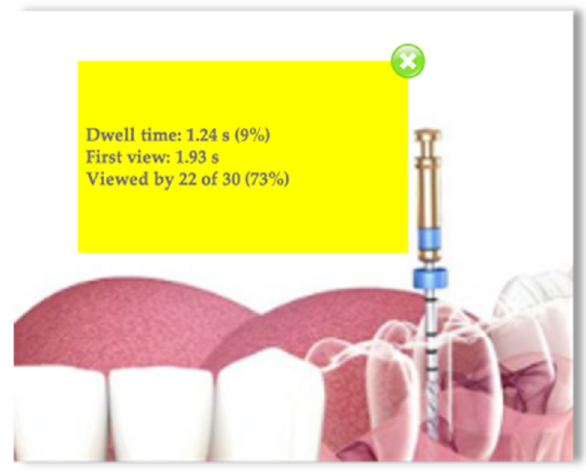
Figure 9. Heatmap analysis: Image A—area 1.